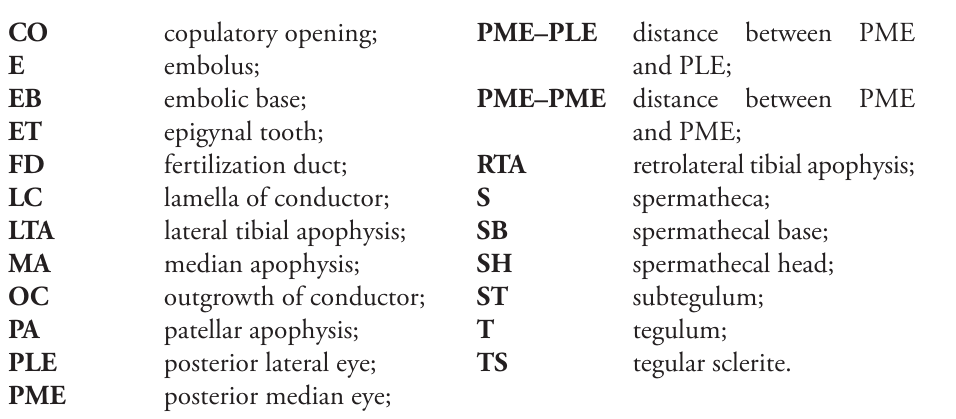
Type species. Guilotes ludiensis Z. Zhao & S. Li, sp.